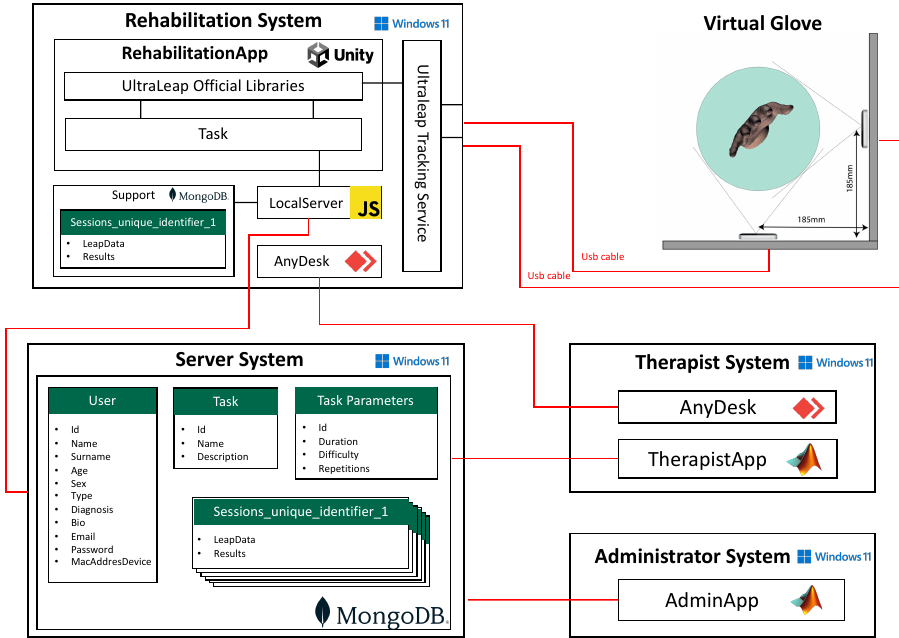
Figure 6. Software architecture diagram representing all the systems involved: Rehabilitation System, Server System, VG, Therapist System, and Administrator